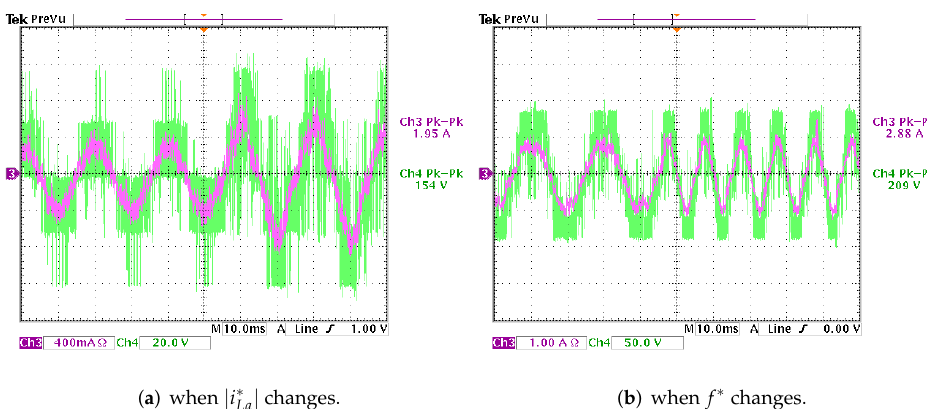
Figure 9. Load current and CHB output voltage in transient